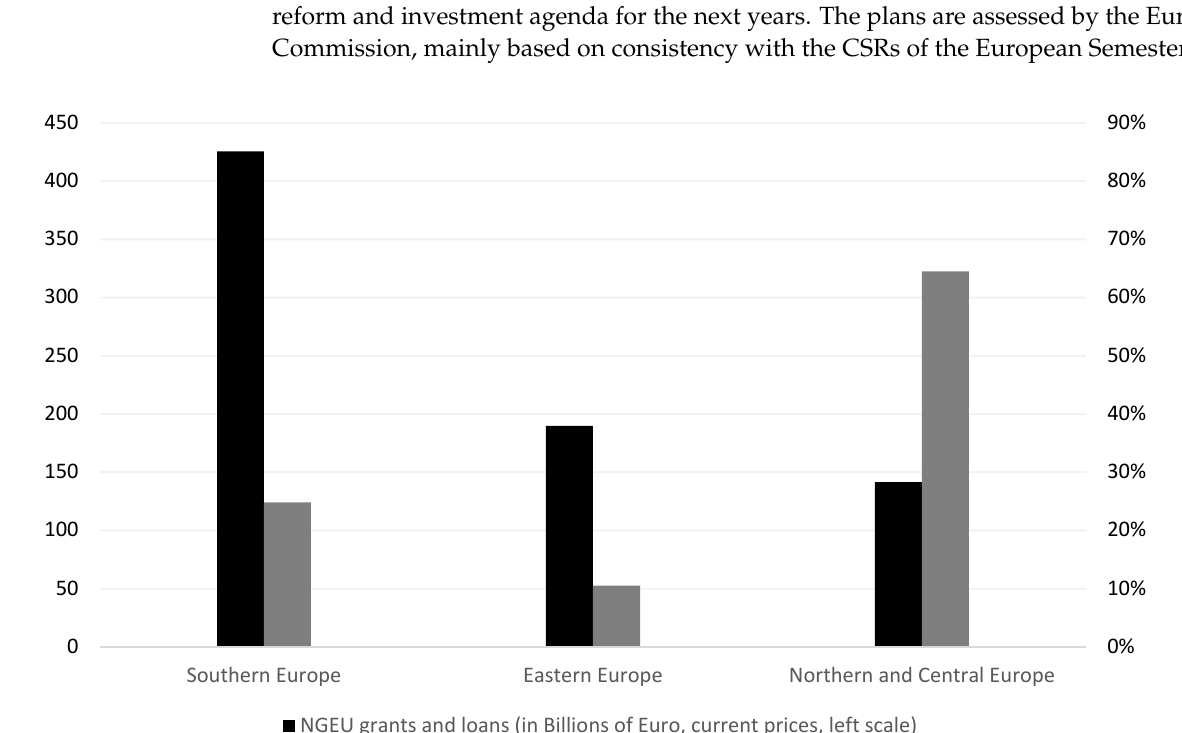
0%10%20%30%40%50%60%70%80%90% 050100150200250300350400450 Southern Europe Eastern Europe Northern and Central Europe NGEU grants and loans (in Billions of Euro, current prices, left scale) National share of EU27 GDP (in percent, right scale) Figure 7. NextGenerationEU (NGEU)—distribution and liability. Notes: Southern Europe: IT, ES, EL, PT, MT, CY. Eastern Europe: BG, HR, CZ, HU, EE, LV, LT, PL, RO, SI, SK. Northern and Central Europe: DE, FR, AT, BE, IE, DK, FI, LX, NE, SE. We assume that all EU member states apply for NGEU grants. We further assume that only those 17 countries that applied for the EU’s SURE loan facility will borrow from NGEU. Source: European Commission, own calculations.